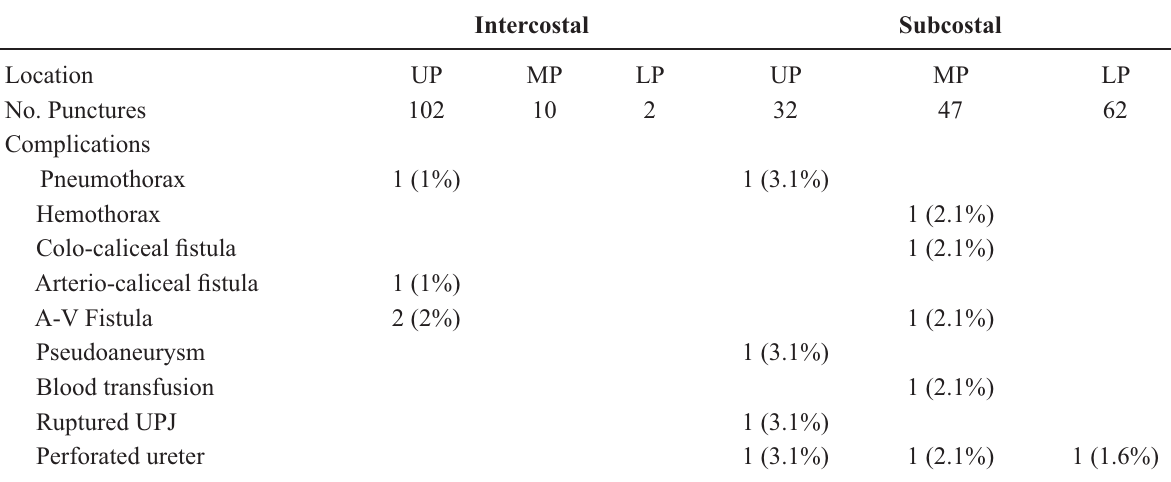
Table 5 – Complications attendant management of staghorn calculi